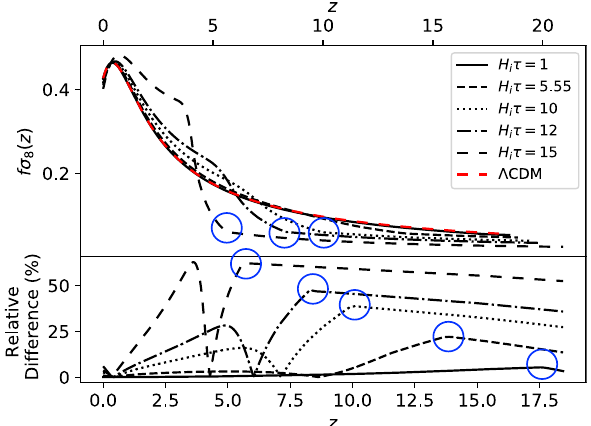
Fig. 10 The evolution of f σ 8 ( z ) . Time-delayed cosmology with inter- mediate (i.e. H i τ ∼ 10) time delay parameter values predict markedly distinct f σ 8 ( z ) evolutions. It is not as pronounced here, but there are also kinks (encircled in blue) in this plot for the time-delayed cosmol- ogy predictions. Note that the non-circled sharp turns on the bottom plot are inflection points produced when taking the absolute value of therelativedifferenceanddonotcorrespondtopredictedphysicalkinks